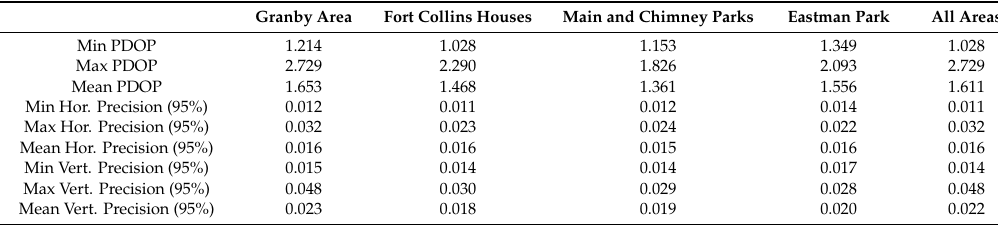
Table 1. GNSS positional